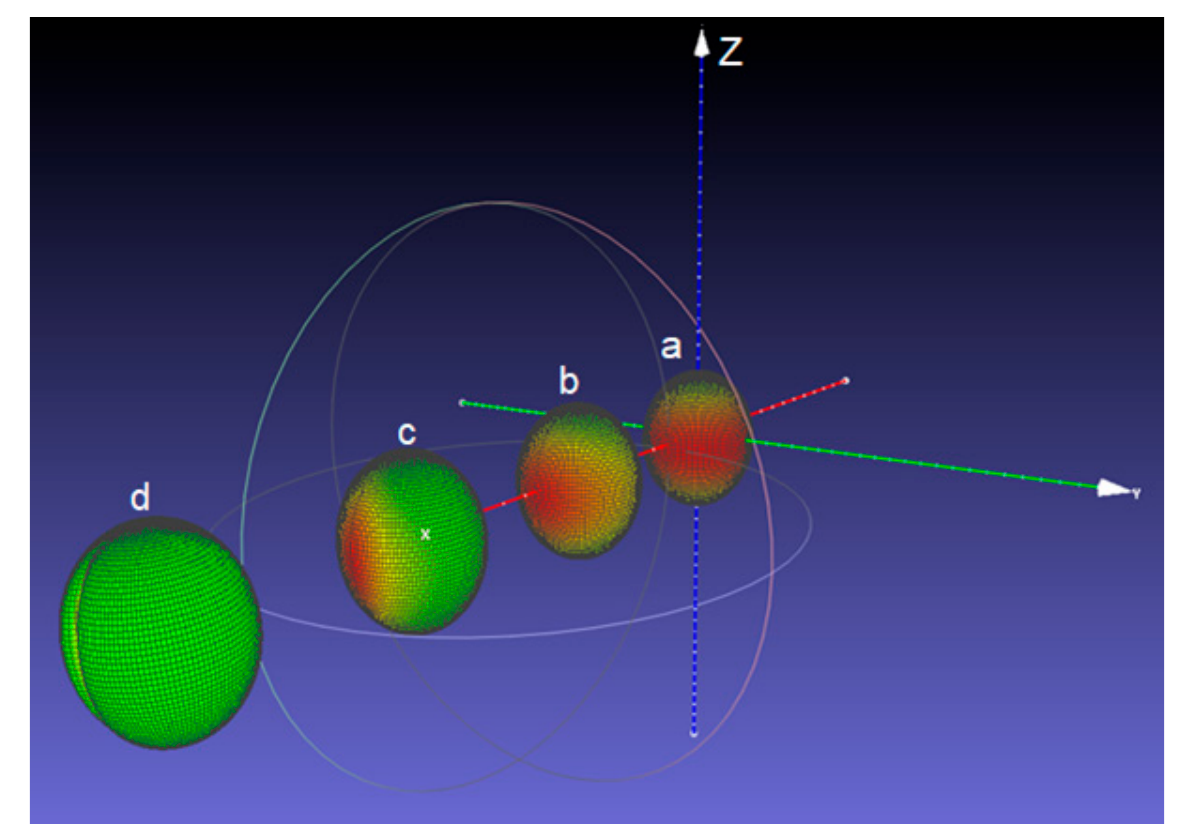
Figure 4. Position of the presented inclusions relative to the blue cylinder axis Oz: 𝑟 = 0 ( a ), 1.47 mm ( b ), 2.93 mm ( c ) and 4.4 mm ( d ).